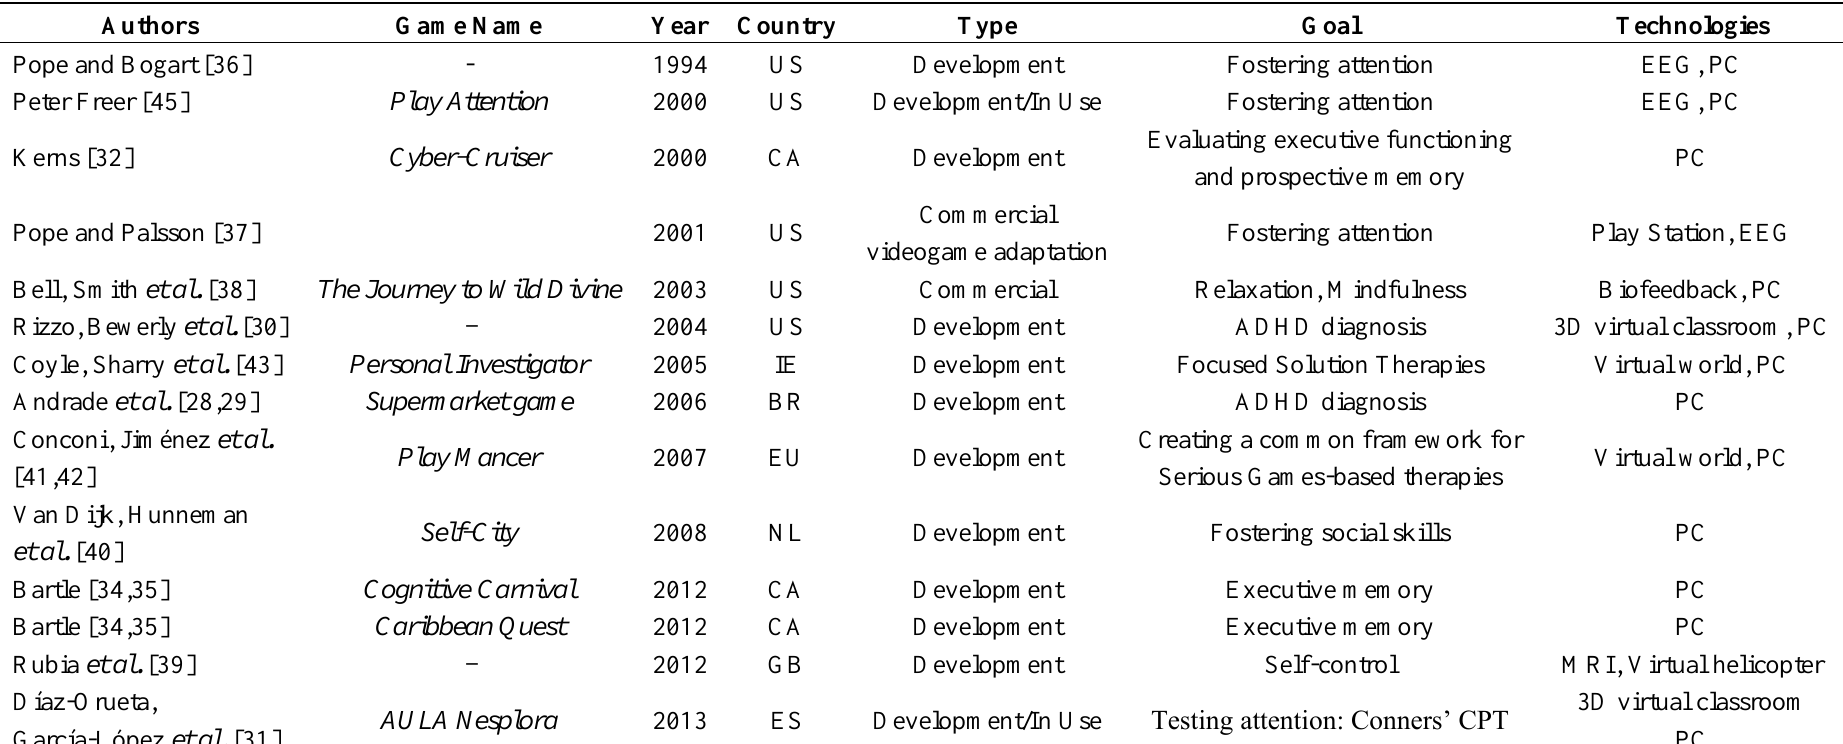
Table 1. Review of Serious Games and